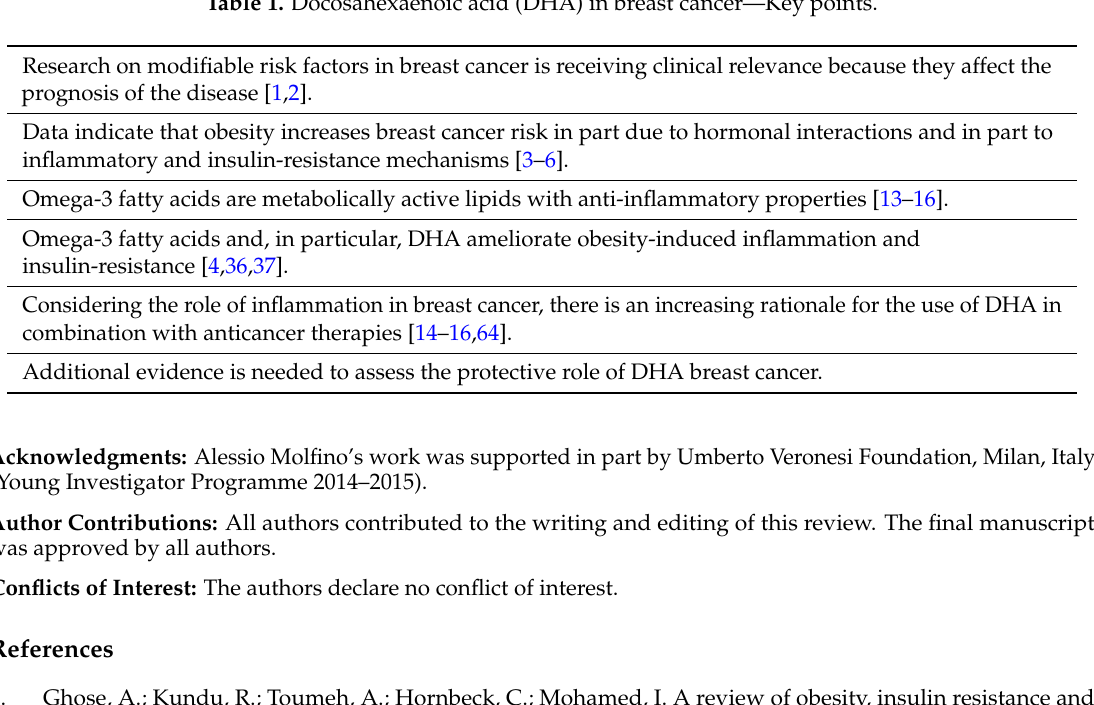
Table 1. Docosahexaenoic acid (DHA) in breast cancer—Key